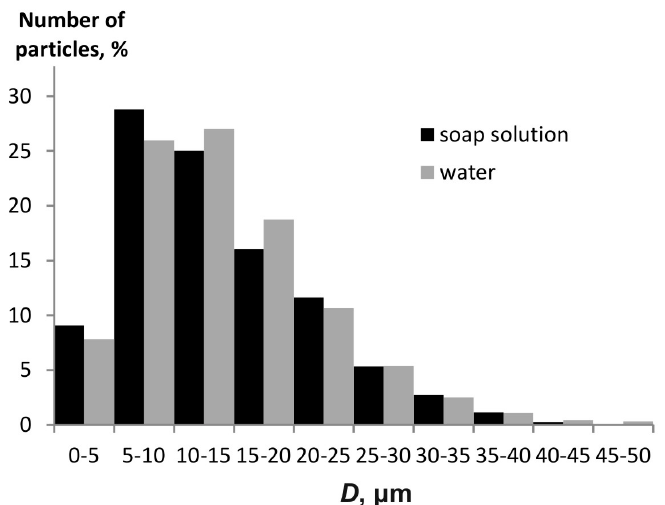
Figure 8. Histogram of the particle size distribution for the water aerosol and soap solution ( P = 4.5 MPa).